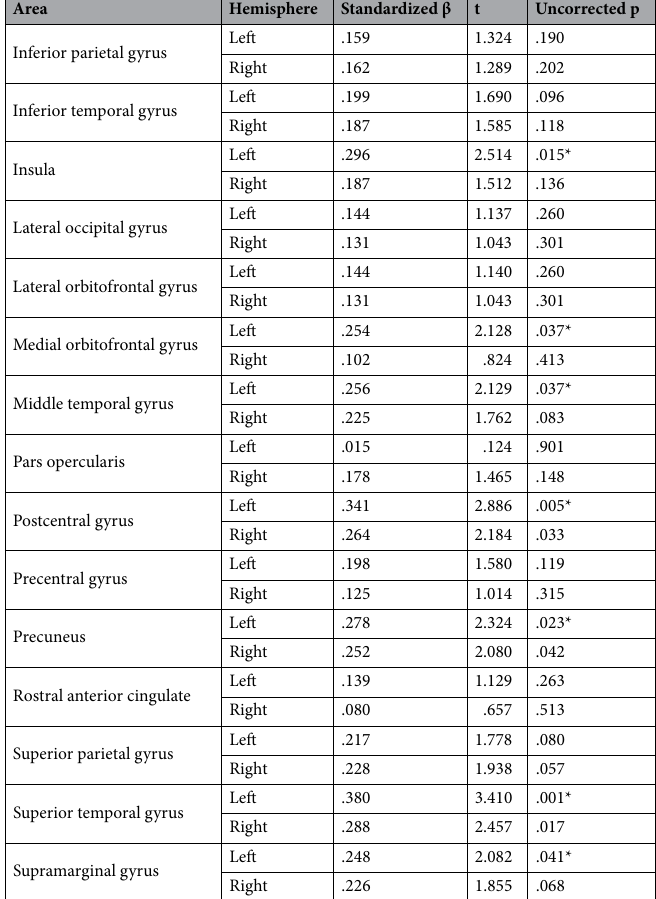
Table 1. The associations between body ownership index and cortical thickness. All estimates were controlled for age, sex and intracranial volume. * Survived the Benjamini–Hochberg procedure (FDR was set at